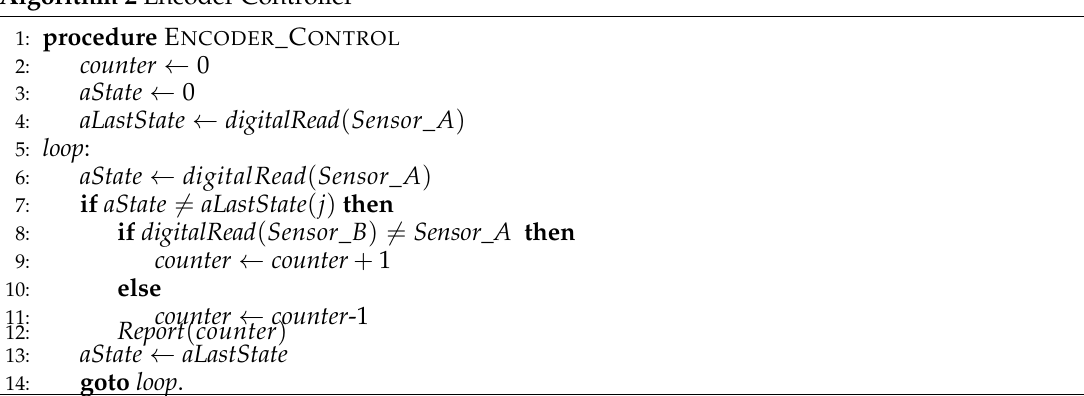
Algorithm 2 Encoder